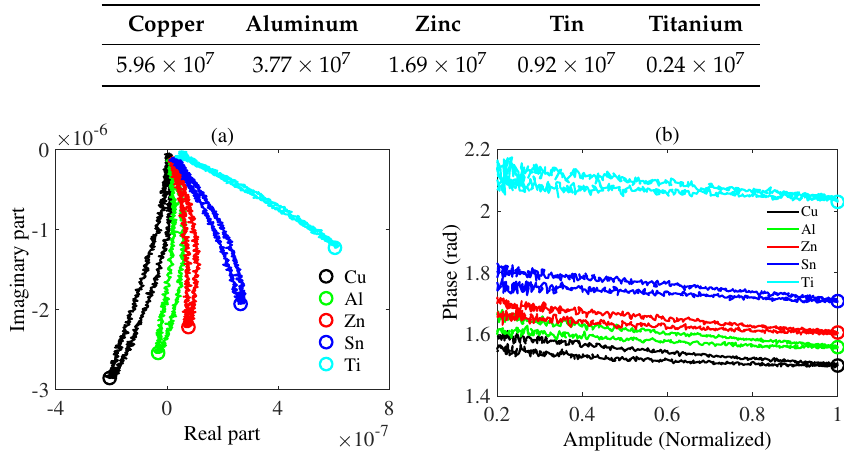
Figure 3. Measured mutual inductances when the excitation frequency is 40 KHz and the lift-off is 5 mm. ( a ) Mutual inductance in the form of a real part and an imaginary part. ( b ) Mutual inductance in the form of amplitude and phase. Trajectories are drawn, where black denotes copper, green denotes aluminum, red denotes zinc, blue denotes tin and cyan denotes titanium. The characteristic phase for each metal is marked by a circle with the same color as the corresponding